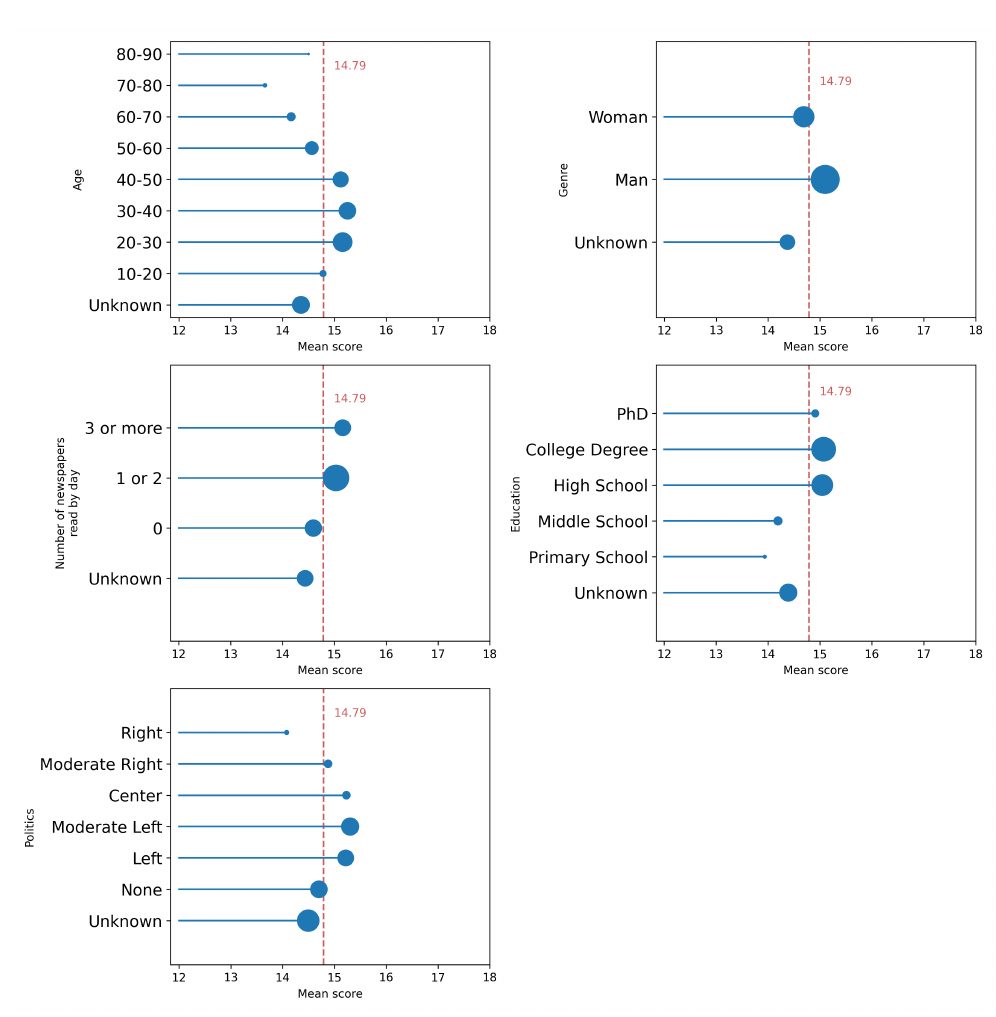
Figure A1. Score distributions by four personal information that users filled into the optional questionnaire. Each lollipop is sized proportionally to the